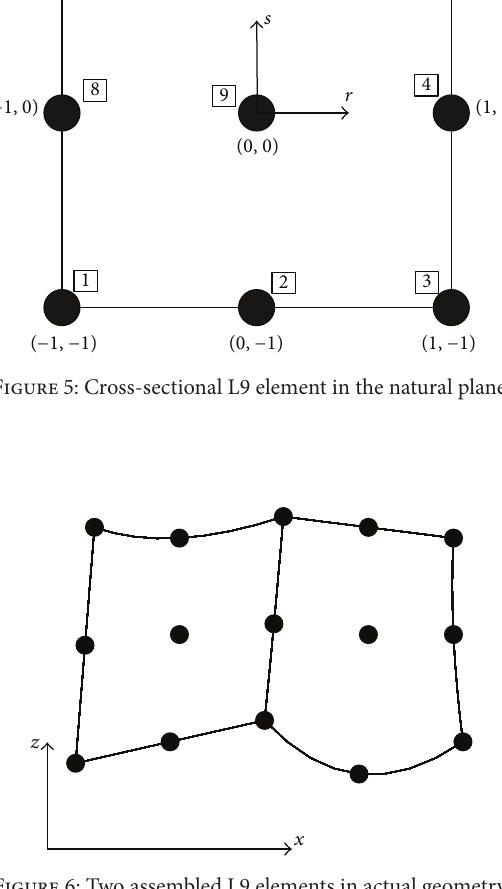
Figure 6: Two assembled L9 elements in actual